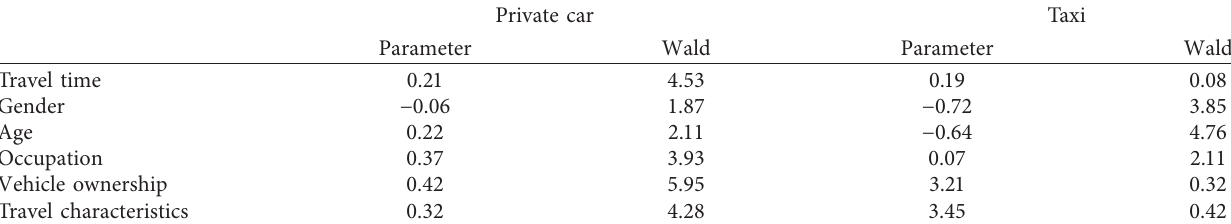
Table 5: Estimation results of characteristic variable parameters of the travel mode selection model.